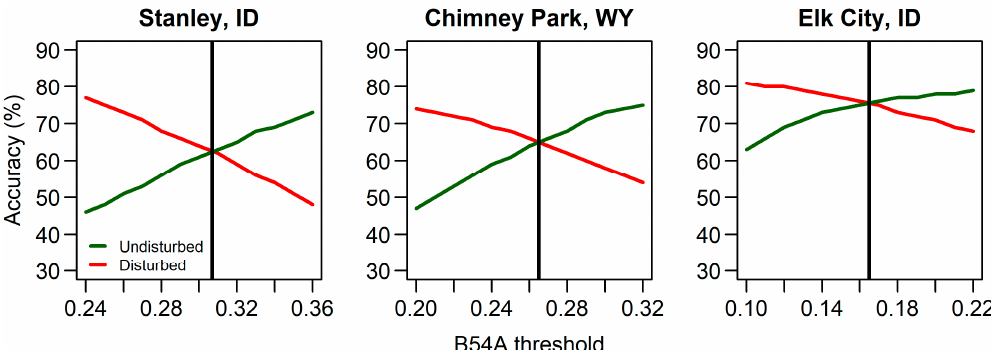
Figure 3. Classification accuracies of undisturbed and disturbed forest classes for various band 5/band 4 anomaly (B54A) values. Vertical lines give B54A thresholds that maximized classification accuracy for disturbed and undisturbed forest in each study area.